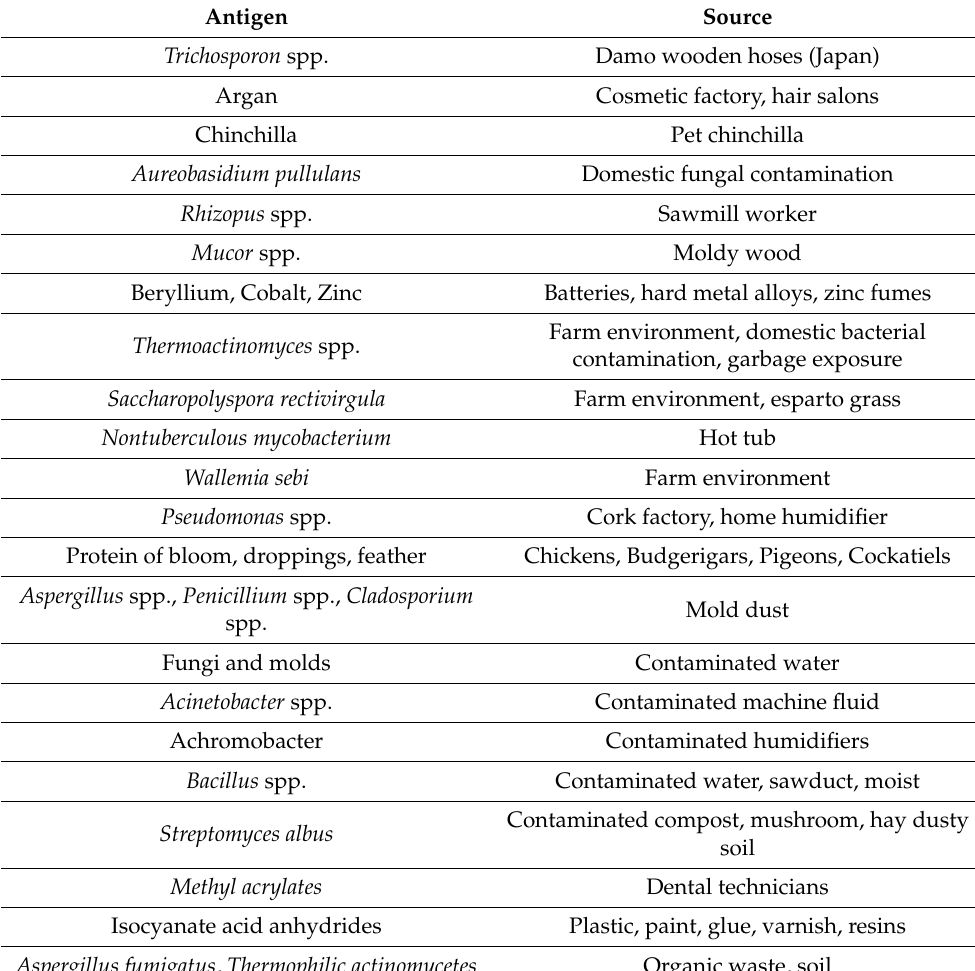
Table 2. Exposures and causal antigens